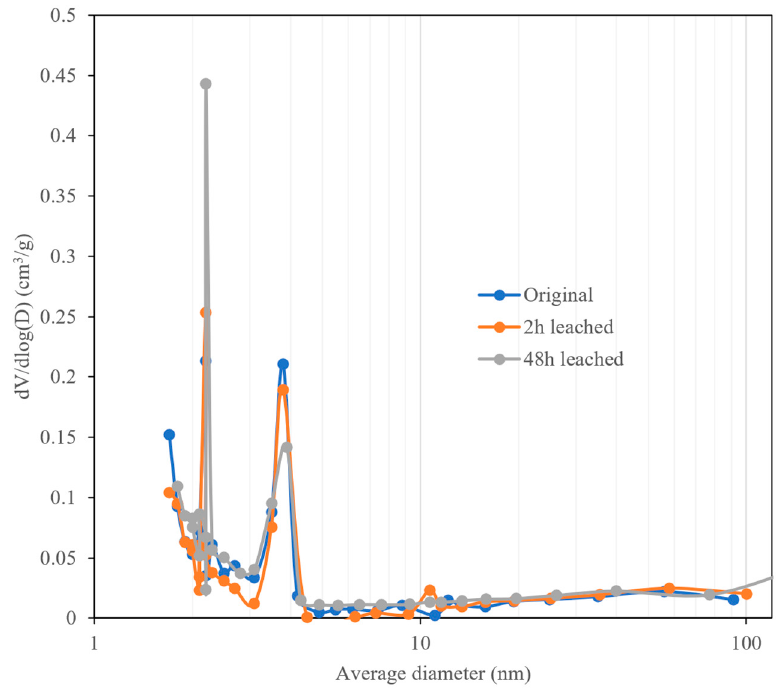
Figure 11. Surface concentrations of the alkali and alkaline earth metal (AAEM) species as a function of char conversion at different temperatures.